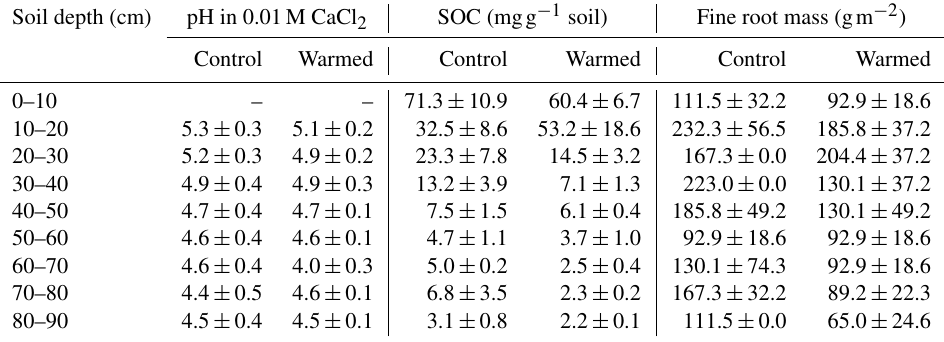
Table 1. pH, concentrations of soil organic carbon (SOC, mgg − 1 soil; Ofiti et al., 2021), and fine root mass (gm − 2 , Ofiti et al., 2021) in control and warmed plots (mean ± SE, n = 3). More details on carbon concentrations on replicated cores can be found in Soong et al. (2021).